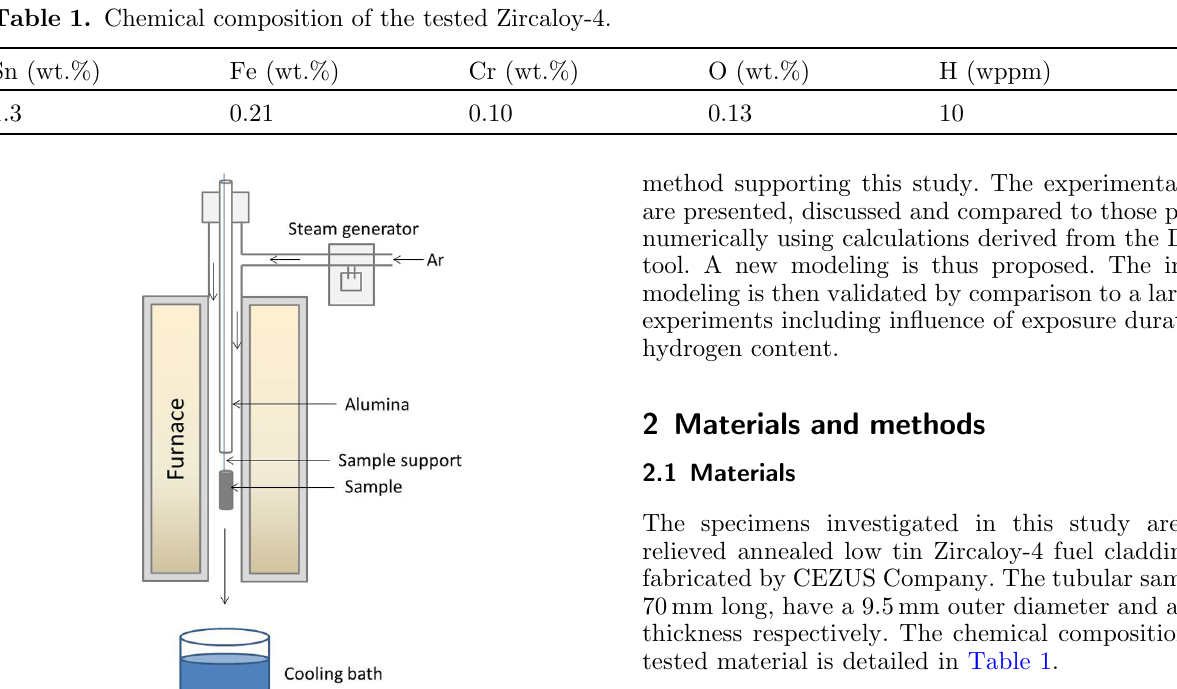
Fig. 2. Vertical furnace used for the steam oxidations at 1200 °